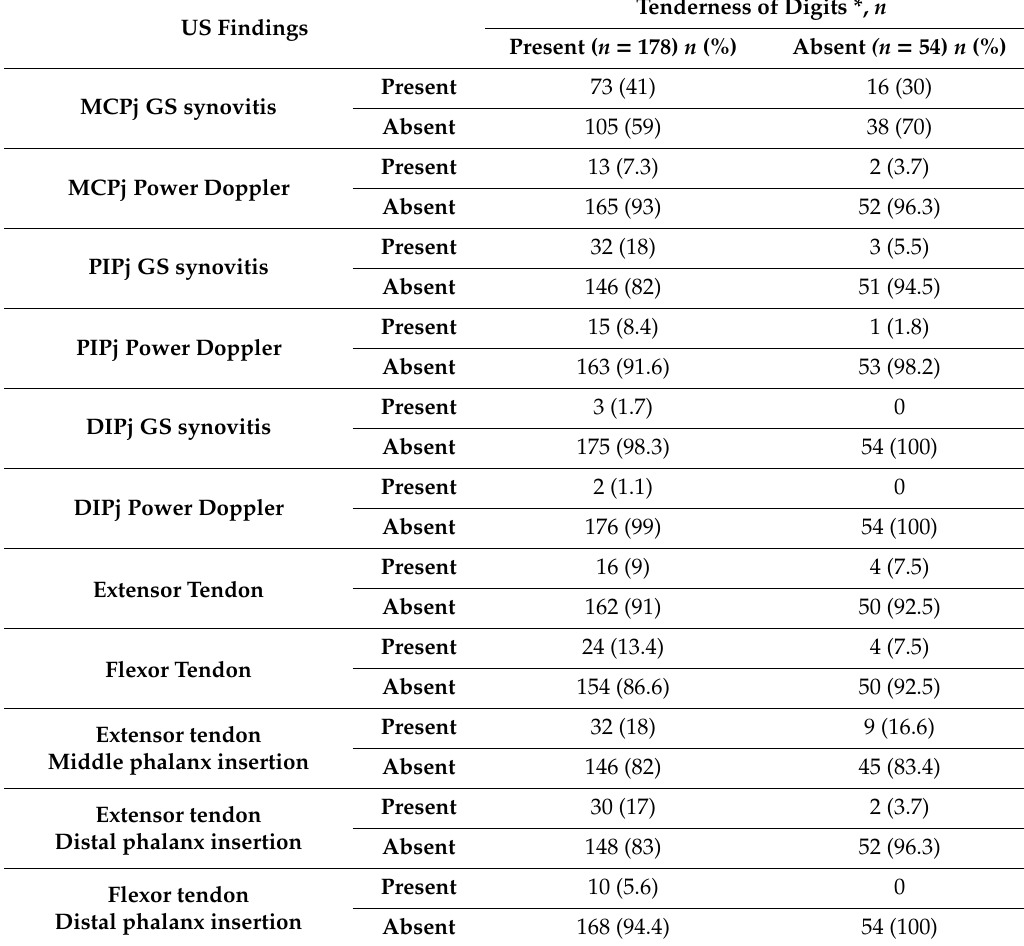
Table 4. Distribution of ultrasonography findings according to